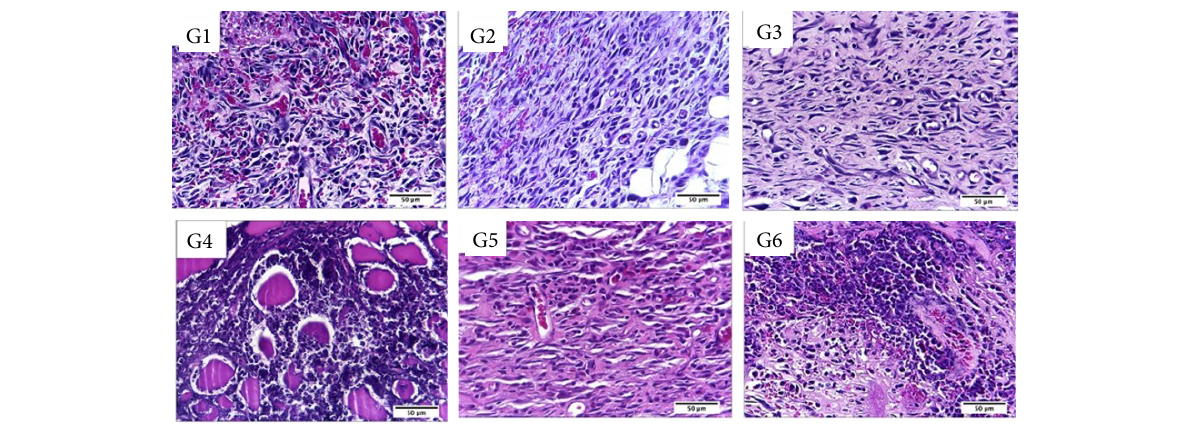
Figure 5 - Microscopic aspects of partial thickness burn wounds experimentally induced in Wistar rats and treated with silver-based dressings 7 DAI, scale bar = 50 μ